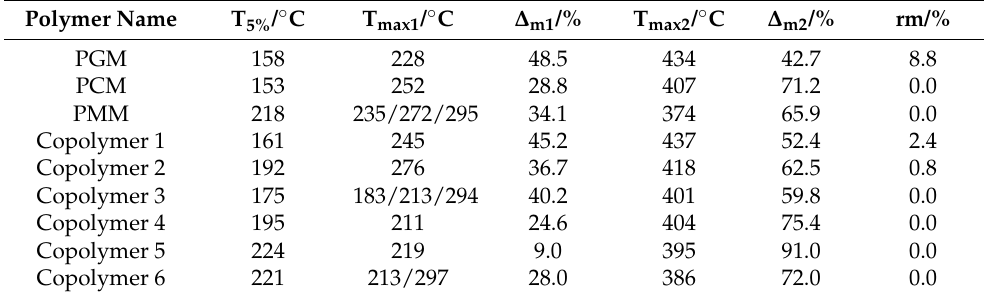
Table 9. TG/DTG data for the materials studied in helium (conditioned at 50 ◦ C—series 1).